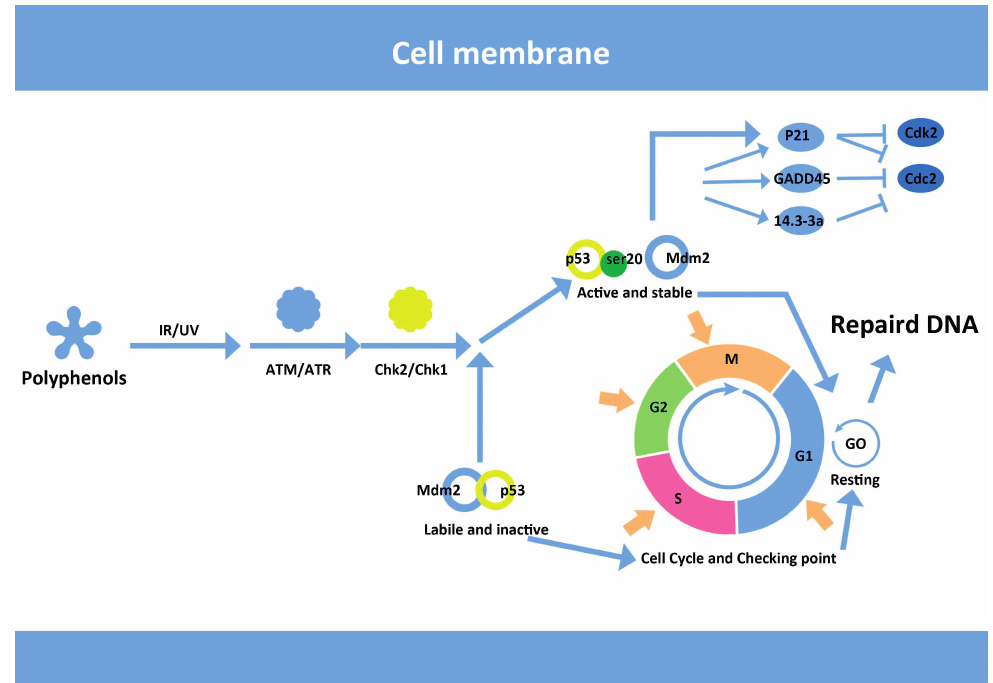
Figure 5. Hypothetical mechanism of DNA repair activation facilitated by blueberry anthocyanins (BA). Following DNA damage after ionizing or ultraviolet radiation (UV), the protein kinases ATM/ATR are activated, which modifies checkpoint-signaling pathways in the cell cycle. This is where BA possibly regulates cellular processes. The diagram is adapted from multiple illustrations based on publicly available materials, particularly a netbook